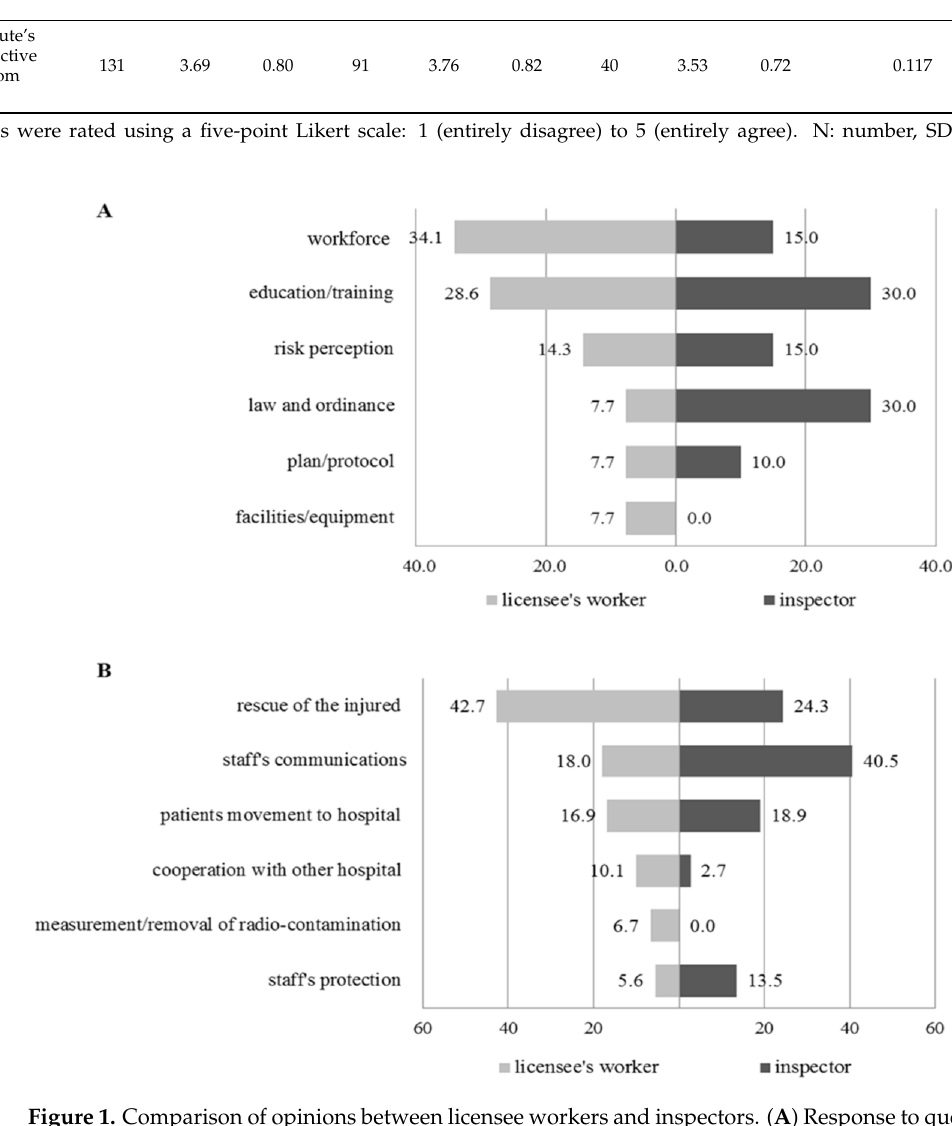
Figure 1. Comparison of opinions between licensee workers and inspectors. ( A ) Response to